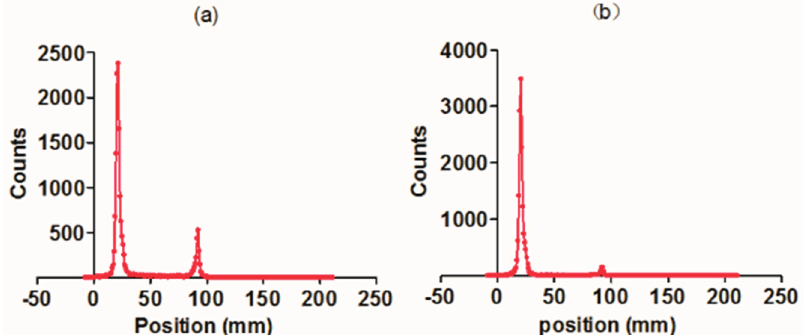
Figure 2. Radiolabeling efficiency and the purity of the 99m Tc-RGD4C β L. The